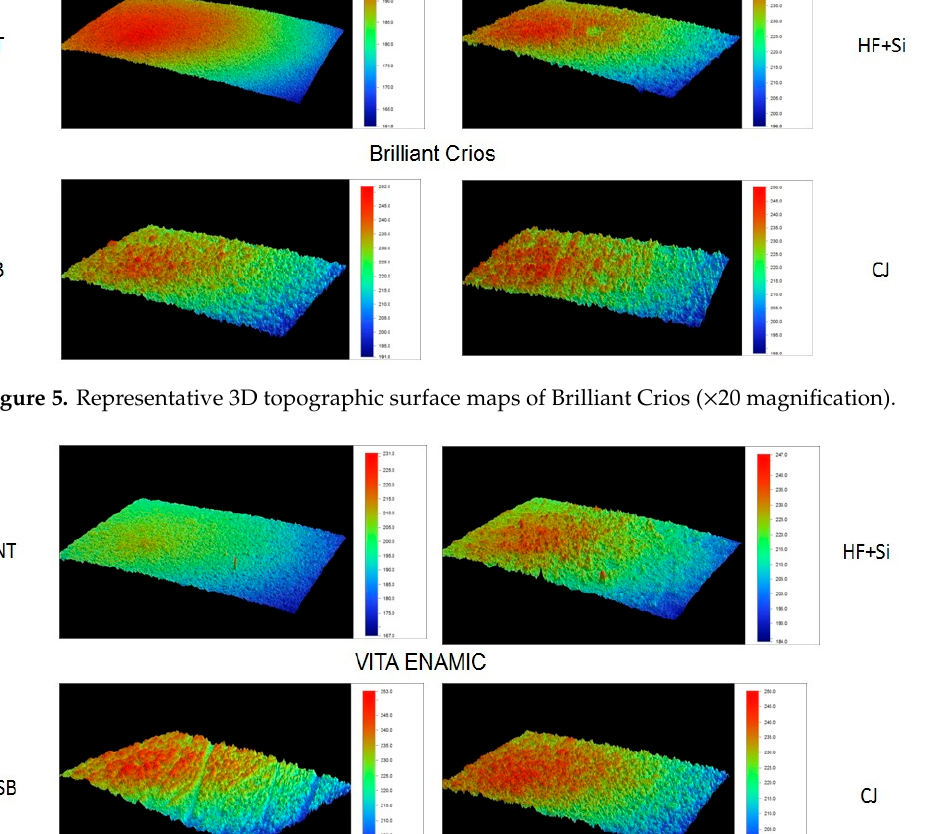
Figure 6. Representative 3D topographic surface maps of Vita Enamic (×20 magnification).